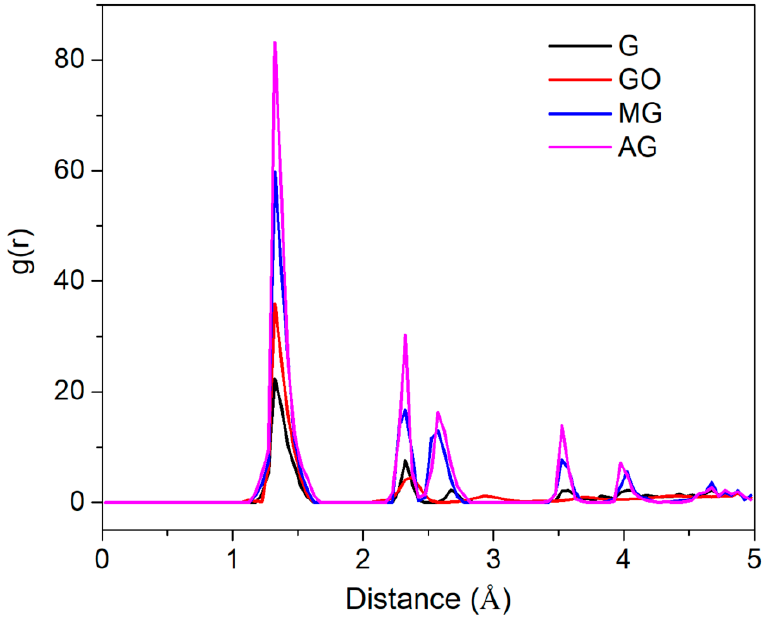
Figure 7. Radial distribution function for graphene-PAO molecules at 300 K and 0.1 MPa from EMD simulations.